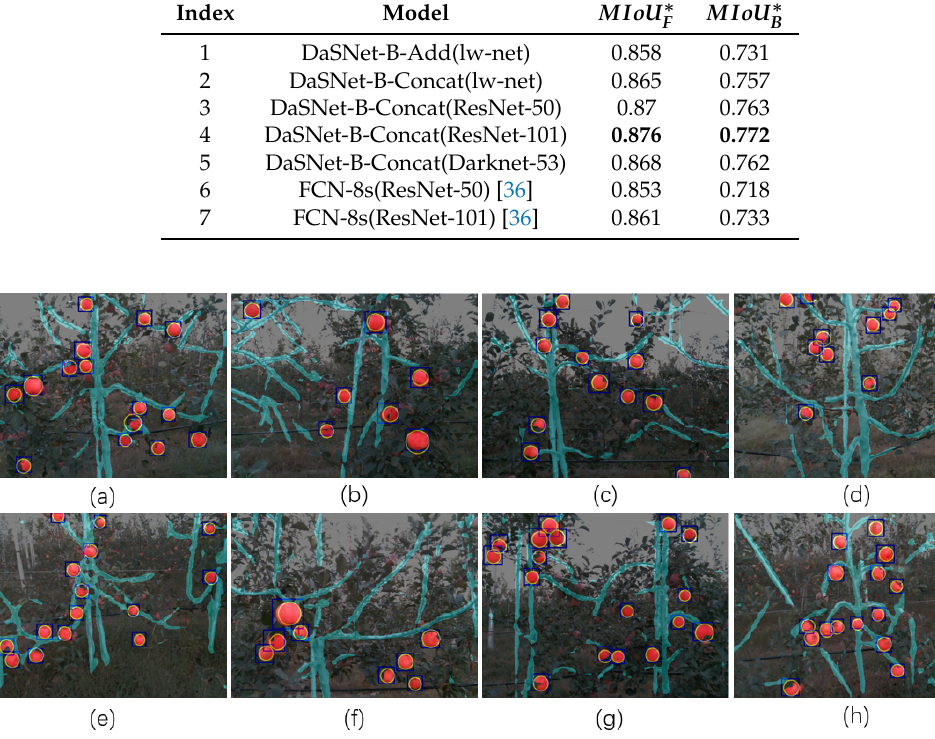
Figure 11. ( a – h ) show the instance segmentation ( ∗ yellow circle) of apples by using the circle hough transform based on the detection and segmentation results of the